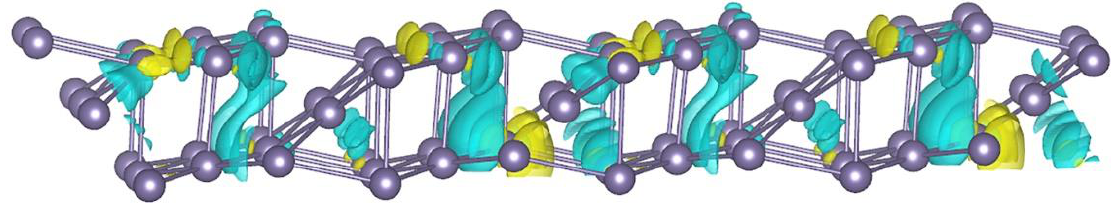
Figure 5. Localization of hole states for three holes in the 2D germanium.